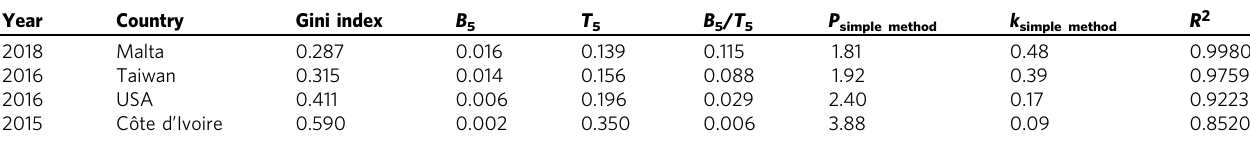
Table 3 The estimated parameters P and k for the Lorenz curves of four countries calculated using the simple method that utilizes the data on the Gini index and the income shares of the bottom 5% and the top 5% as published in the UNU-WIID.